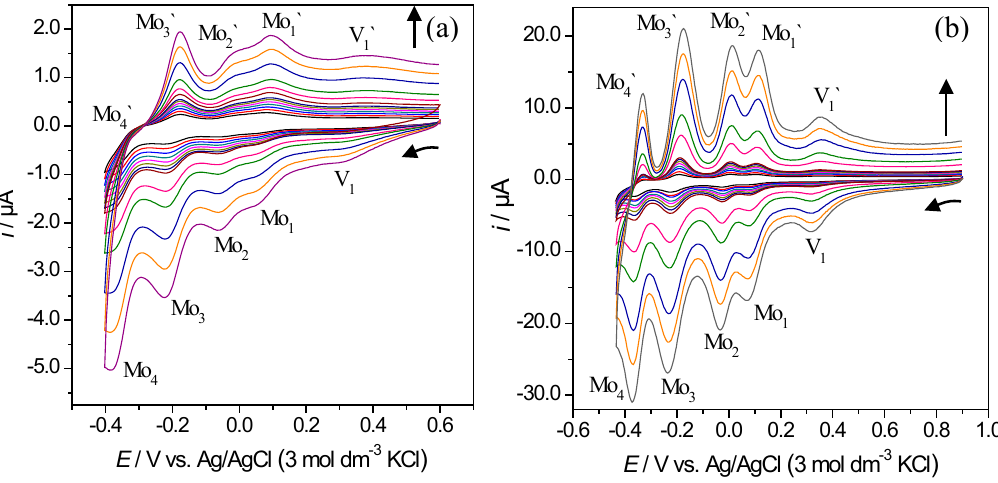
Figure 2. Cyclic voltammograms in pH 2.5 H 2 SO 4 /Na 2 SO 4 buffer solution at different scan rates from 0.02–0.5 V s − 1 of PMo 11 V ( a ) and PMo 11 V@N-FLG ( b ).